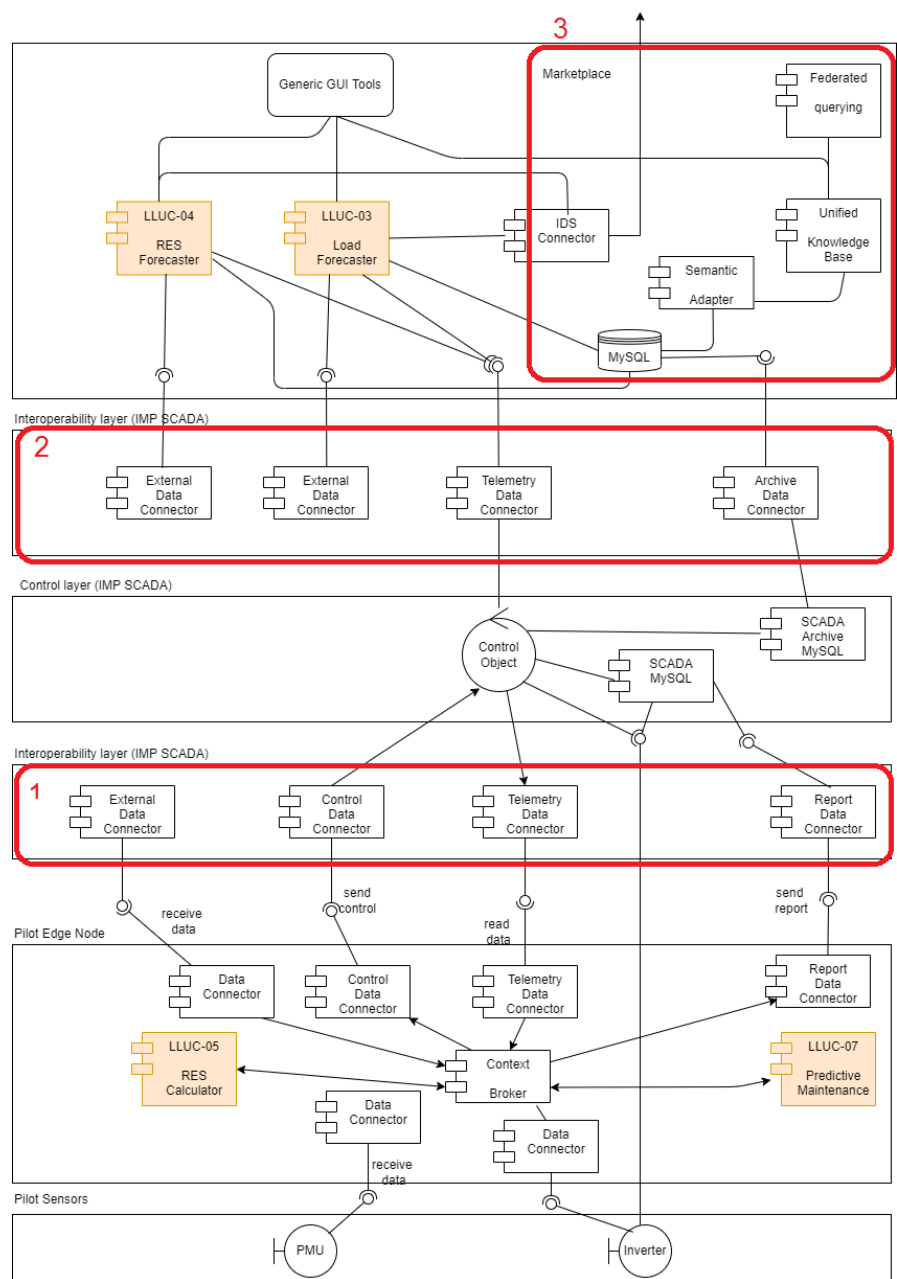
Figure 3. Software architecture for one node (Institute Mihajlo Pupin,